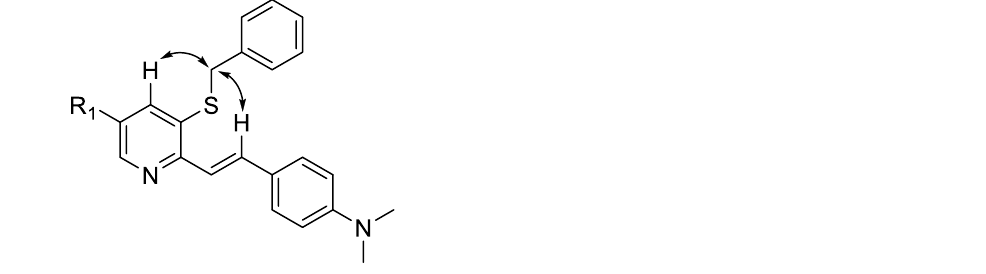
Figure 3. Cross-peaks observed in 1 Н - 1 Н NOESY spectrum of compounds 5m (R 1 = NO 2 ) and 5q (R 1 = Br).